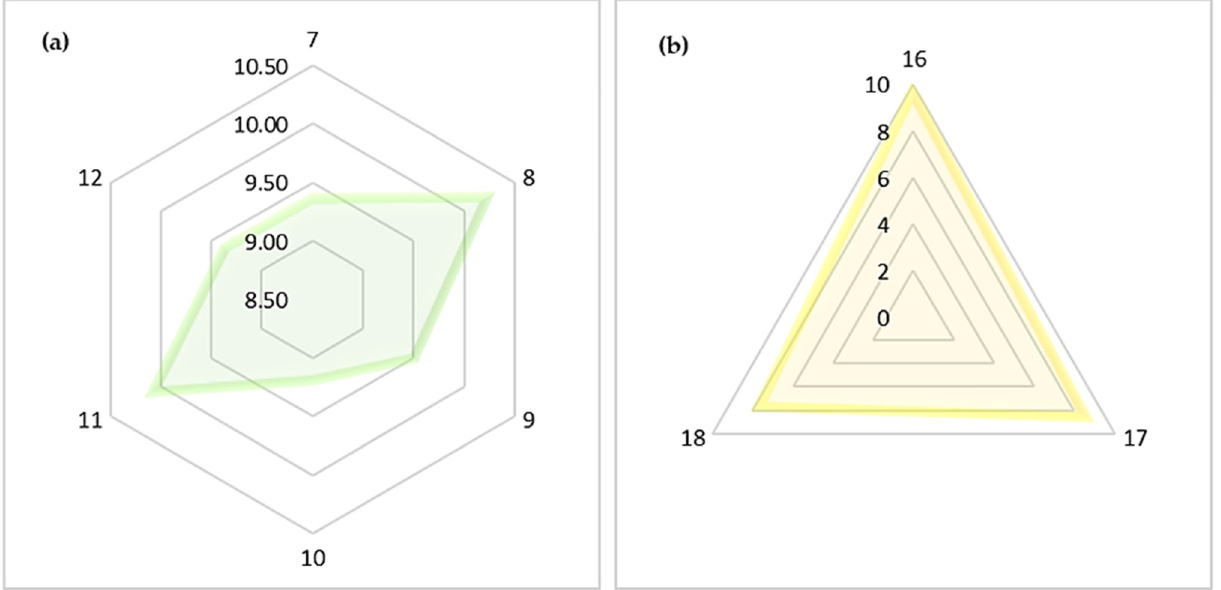
Table 14. LCOE analysis for a solar power tower plant of 100 MW installed capacity with nano-